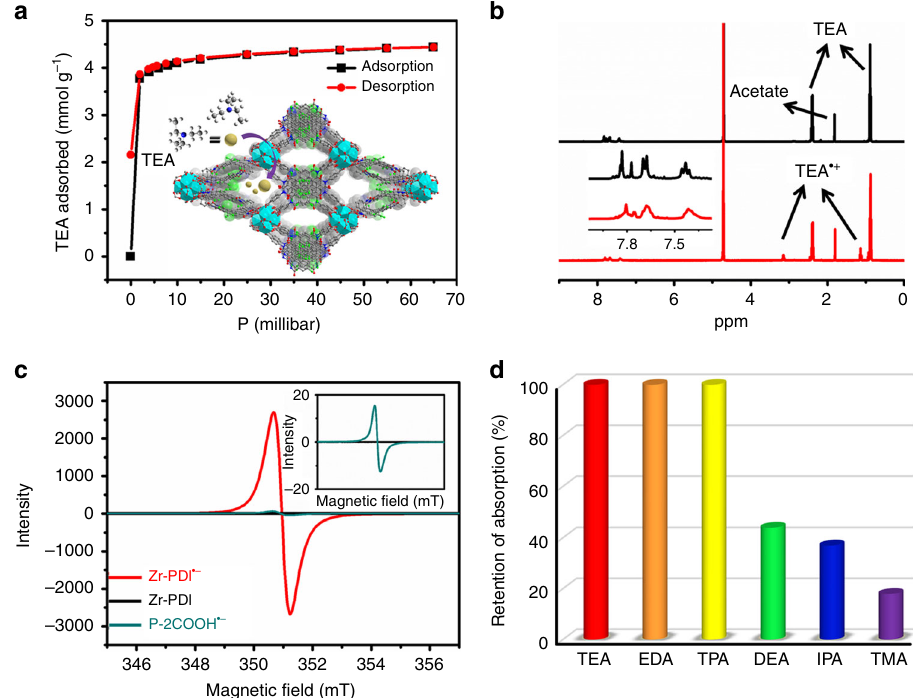
Fig. 3 Characterizations of Zr-PDI (cid:129) − . a TEA adsorption and desorption of activated Zr-PDI; inset shows TEA vapor in Zr-PDI channel. b 1 H NMR spectra of TEA-loaded Zr-PDI before (black line) and after (red line) irradiation; inset shows the peaks of PDI. c EPR spectra of solid Zr-PDI (cid:129) − and P-2COOH (cid:129) − ; inset shows the magni fi ed spectrum of P-2COOH (cid:129) − . d Stability of Zr-PDI (cid:129) − loaded with different amines under ambient conditions after a week. The ordinate represents the retention rates of the absorption peak at 1008 nm. TEA triethylamine, EDA ethylenediamine, TPA tripropylamine, DEA diethylamine, IPA isopropylamine, TMA